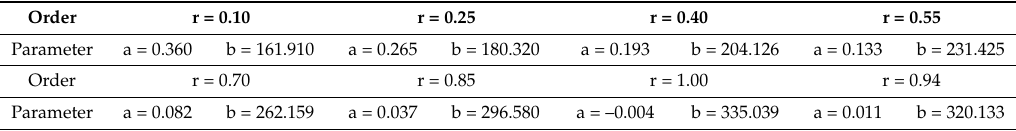
Table 2. The parameters of the DWSGM (1,1) model with different